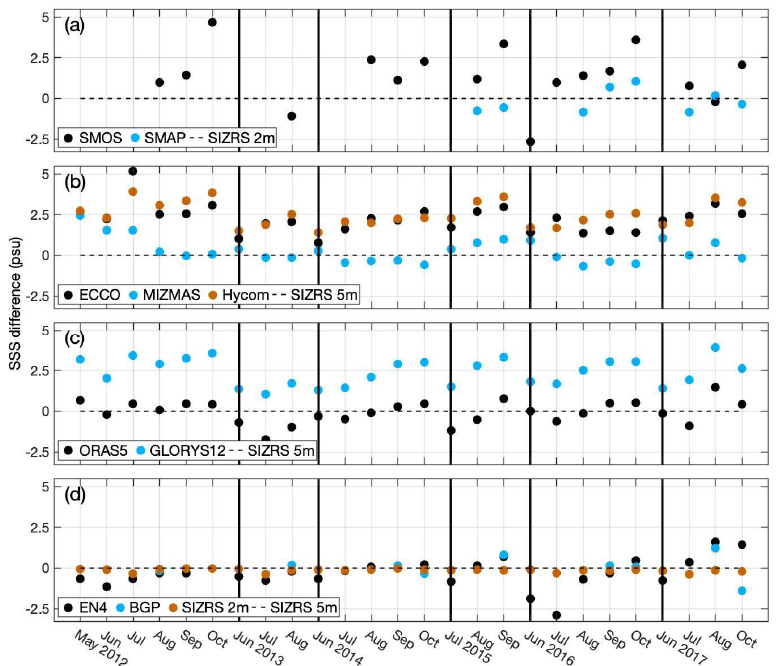
Figure 7. Sea surface salinity (SSS) differences (psu) from SIZRS (at 5 m) averaged along (150 ◦ W from 70.5 ◦ N–80.5 ◦ N) compared to ( a ) satellite missions, ( b , c ) ocean model simulations, and ( d ) in–situ observations. Grey, vertical lines separate years where months are not consecutive.